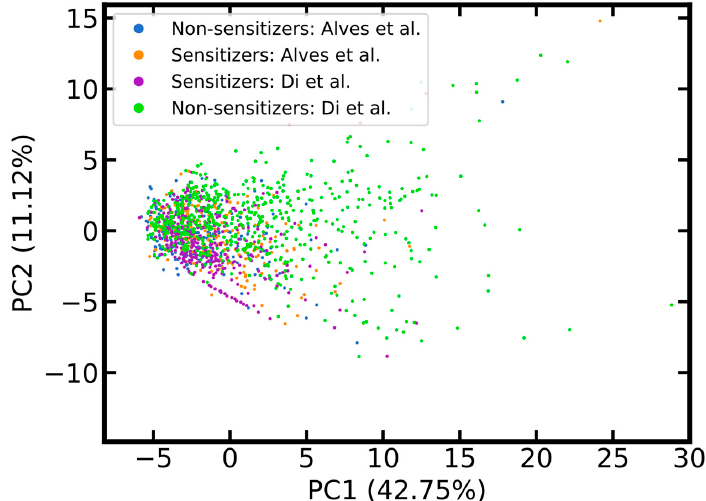
Figure 3. Score plot comparing the chemical space of compounds of the local lymph node assay (LLNA) data sets of Alves et al. and Di et al. The score plot was derived from a PCA based on the identical setup described in the caption of Figure 1. Two data points are located outside the displayed intervals.